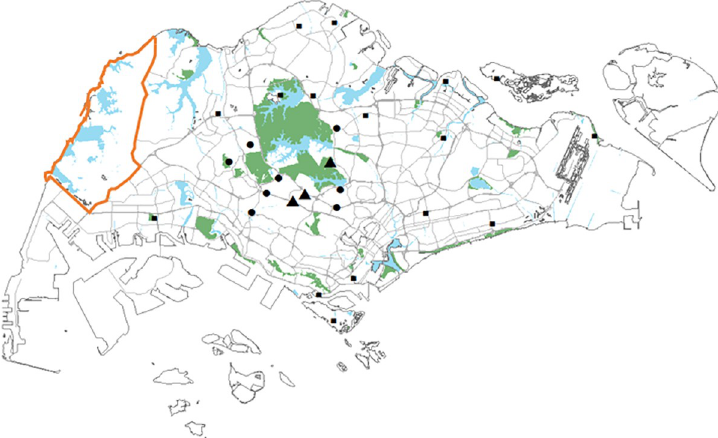
Fig 1. Distribution of macaques caught and screened for this study from Jan 2008 to Mar 2017. Western Catchment Area, the forest where all the wild macaques were trapped, is outlined in orange. Peridomestic macaque trapping locations were denoted by square, circle, and triangle for trapped macaque counts of less than 10, 10 to 49 and more than 50 respectively. (The map was downloaded from